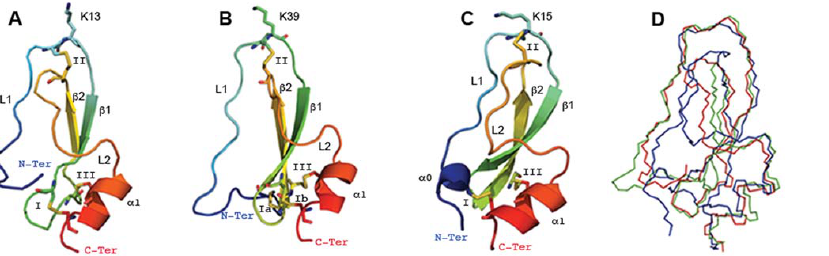
Figure 5. A–D. Tryptogalinin predicted tertiary structure. The modeled tryptogalinin (A), TdPI (PDB: 2UUX) (B) and BPTI (PDB: 5PTI) (C) depict the conserved disulfide bridges (indicated by roman numerals), loops (L1 and L2), the beta-sheets ( b 1– b 2) that form the b-hairpin, the alpha-helixes ( a 0 and/or a 1) and the Lys (K) that interacts with the active site of serine proteases. The C a superimposition (D) of tryptogalinin (red), TdPI (green) and BPTI (blue) show the similarities/differences in their overall structures.